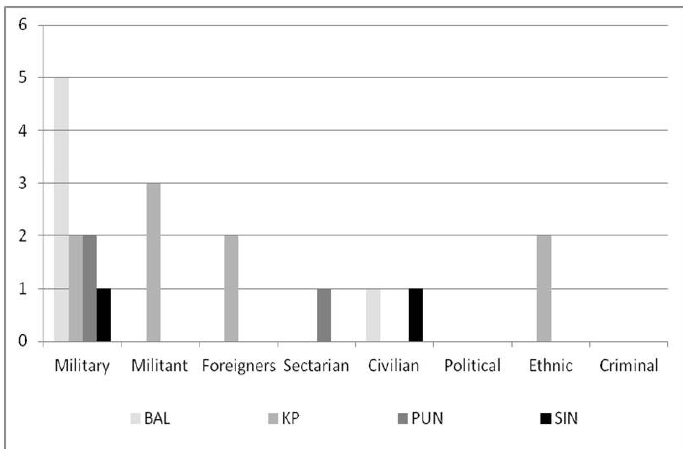
Figure 5. Number of Event–Target clusters for different Target Killing types.